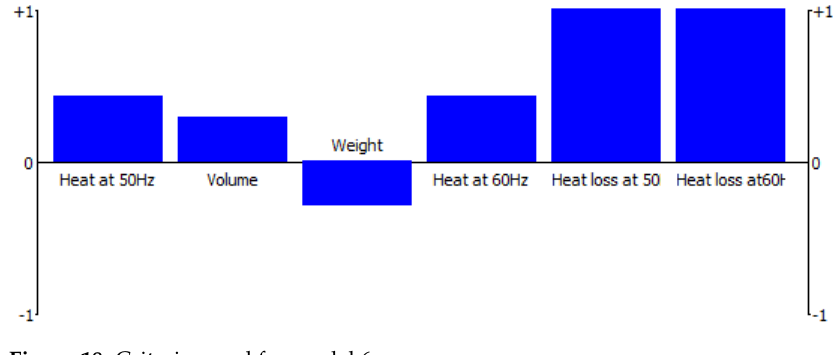
Figure 18. Criteria panel for model 6.